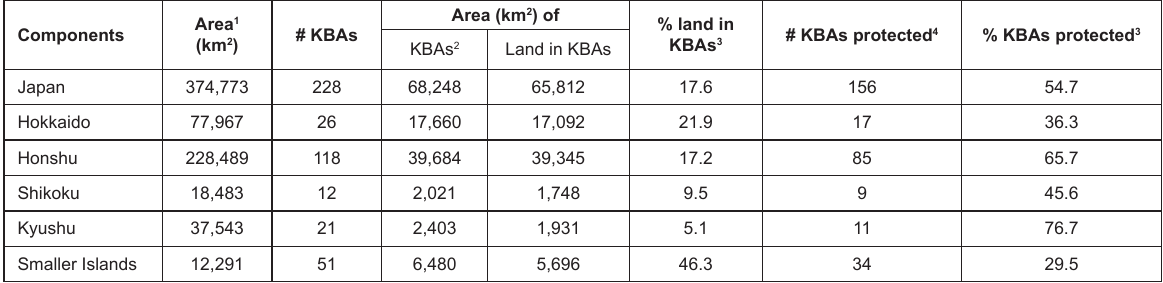
Table 3. Area, number, coverage and protected-area status of KBAs in the Japan Hotspot and its components